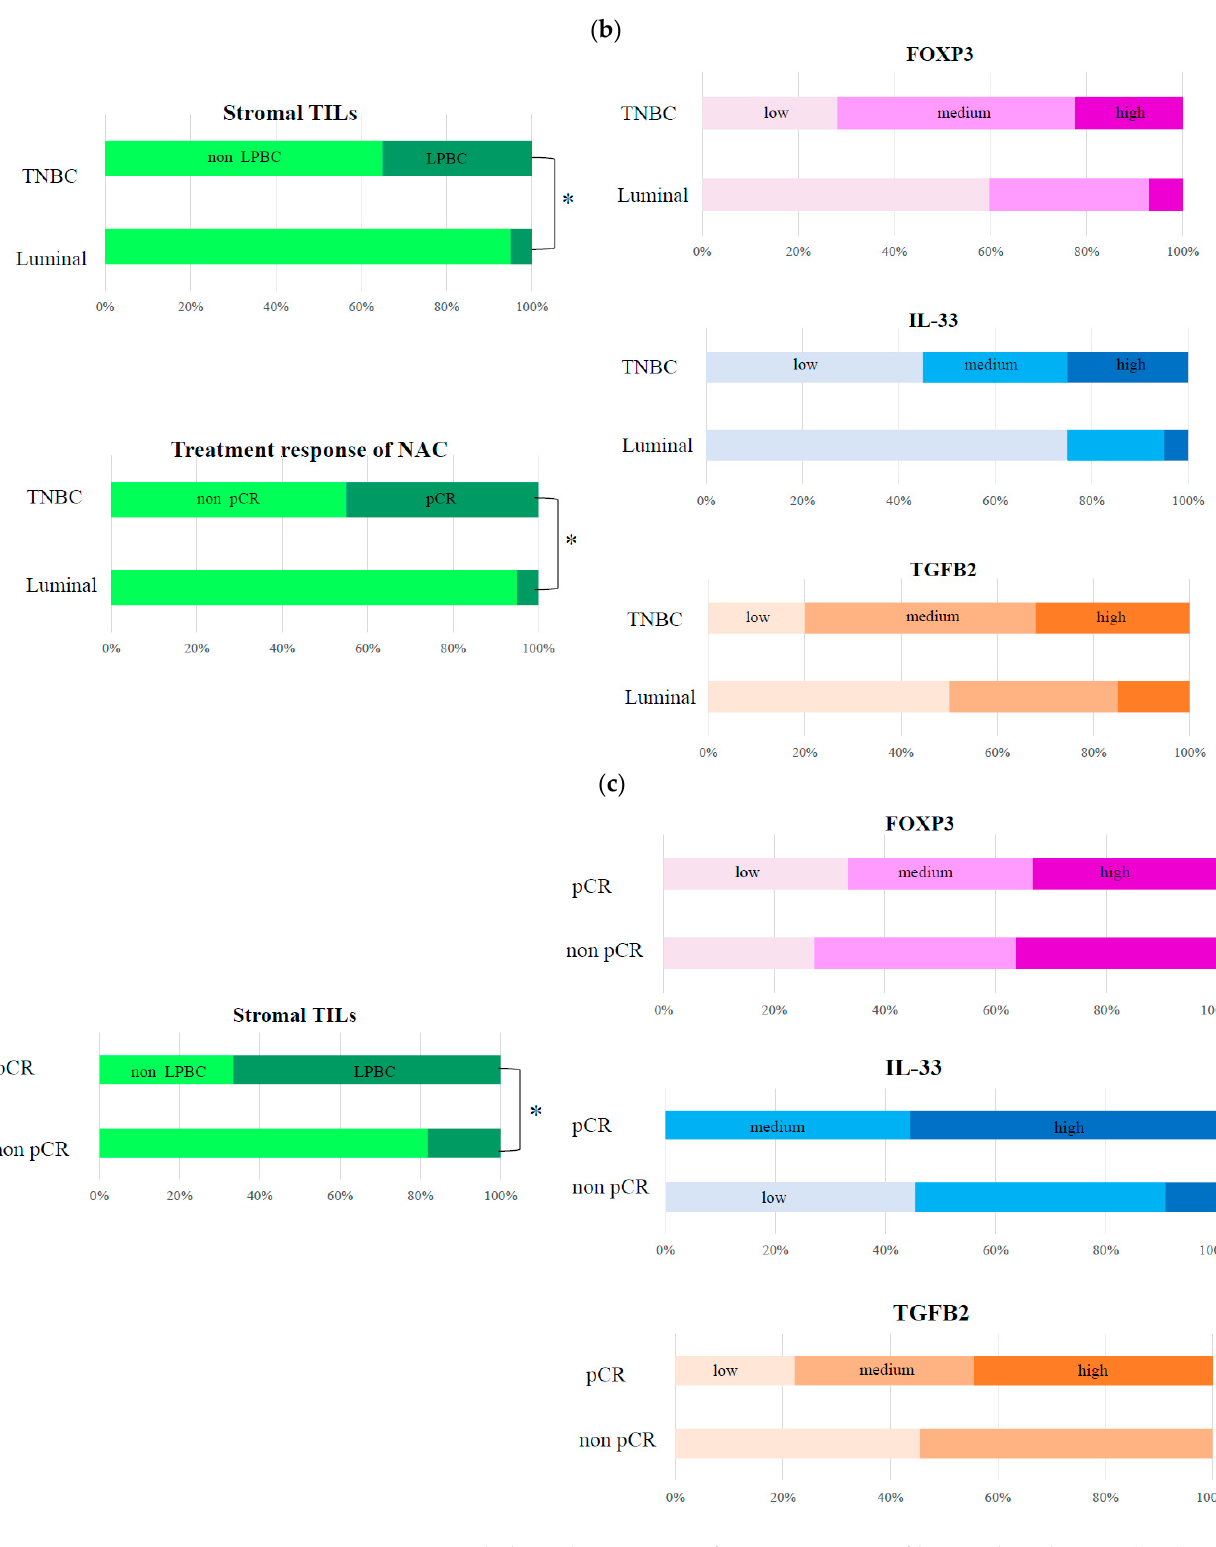
Figure 3. Histopathological assessment of FOXP3+ tumor-infiltrating lymphocytes (TILs) in TNBC and luminal subtype biopsy samples of patients who underwent neoadjuvant chemotherapy (NAC). All samples (TNBC, n = 20; luminal, n = 20) were obtained by biopsy of tumors before NAC. ( a ) Immunohistochemical staining of FOXP3, IL-33, and TGFB2 markers, and (above) non-lympho- cyte-predominant breast cancer (LPBC) (stromal TILs < 50%) and (below) LPBC (stromal TILs ≥ 50%). Representative ×100 magnification and ×400 magnification (top right) images of each case. ( b ) Details about the incidence of stromal TILs (non-LPBC/LPBC), treatment response to NAC (non-